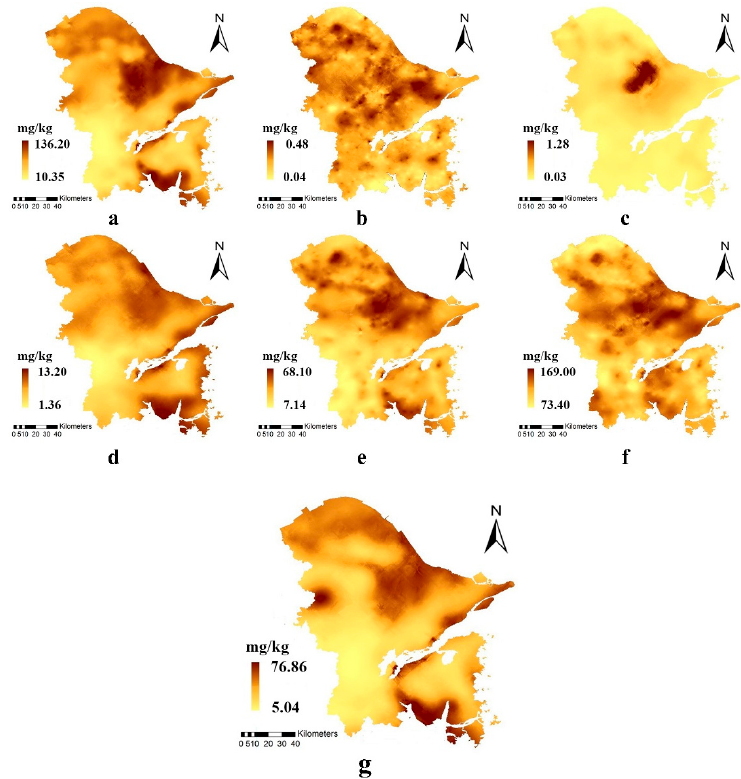
Figure 4. Spatial distributions of ( a ) Cr; ( b ) Cd; ( c ) Hg; ( d ) As; ( e ) Cu; ( f ) Zn; and ( g ) Ni.